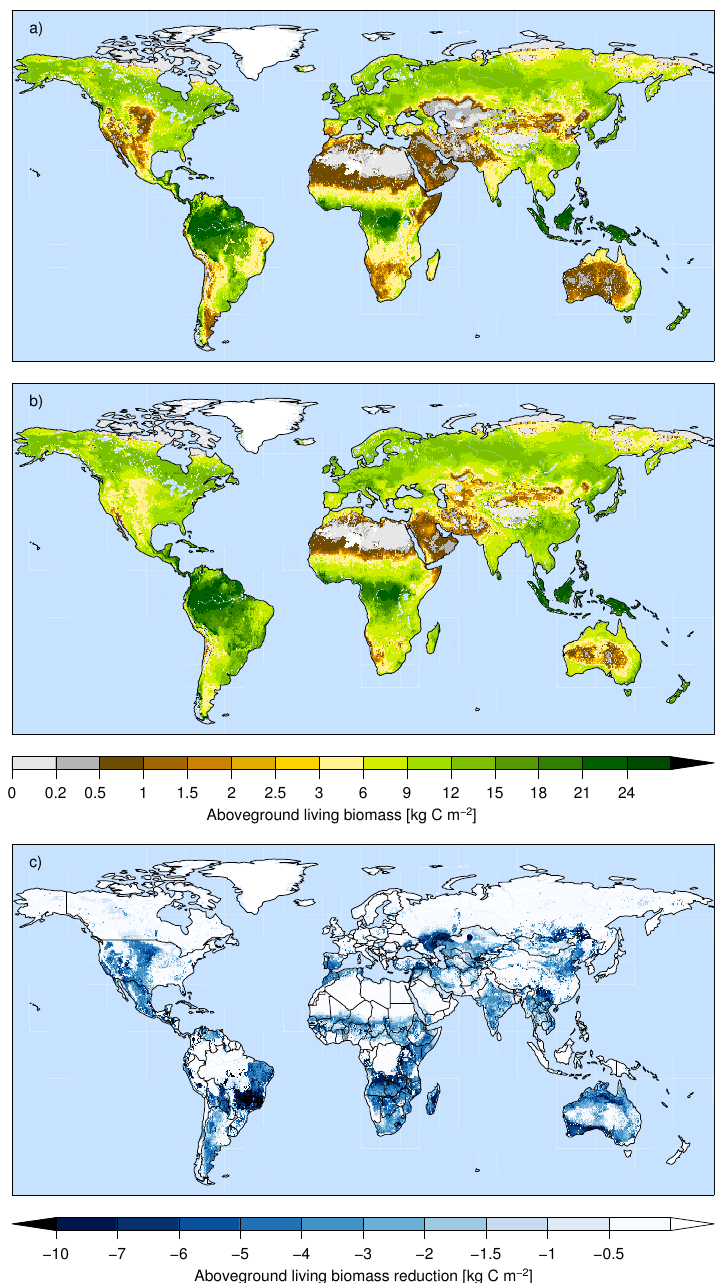
Fig. 10. Simulated biomass C: (a) human absence, lightning fires; (b) human absence, no fire; (c) reduction in biomass C between (a) and (b)